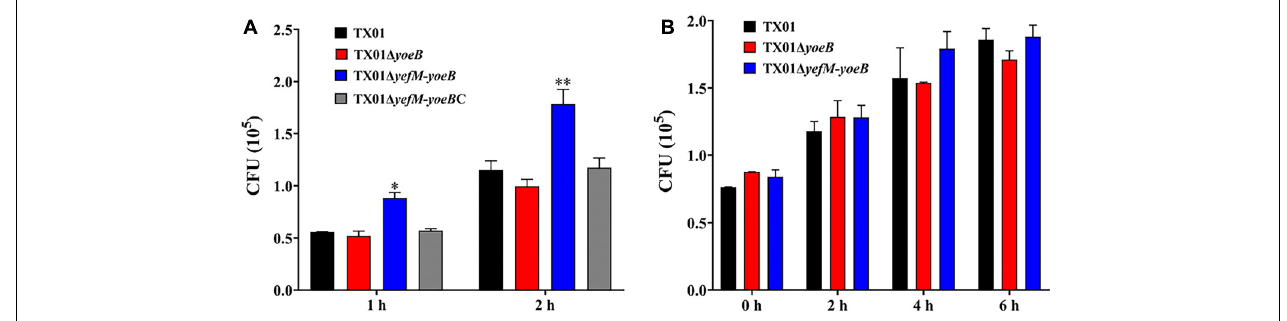
FIGURE 5 | Effects of yeoB and yefMyeoB mutation on cellular infection and replication. (A) The association and invasion of E. piscicida to flounder gill cells (FG cells). FG cells were infected with the same dose of TX01, TX01 (cid:49) yeoB , TX01 (cid:49) yefMyeoB , and TX01 (cid:49) yefMyeoB C for various time and washed with PBS. Then the FG cells were lysed, the bacteria associated with and invaded into the host cells were determined by plate counting. (B) Survival and replication of E. piscicida in mouse macrophage cell RAW264.7. RAW264.7 cells were hatched with TX01, TX01 (cid:49) yeoB , TX01 (cid:49) yefMyeoB for 2 h, then the mouse macrophages were treated with gentamicin for 2 h. After the cells were incubated with bacterial for various hours, the number of intracellular bacteria was determined by plate counting. Data are presented as the means ± SEMs ( N = 3). N, the number of times the experiment was performed. ∗ P < 0.05; ∗∗ P < 0.01.